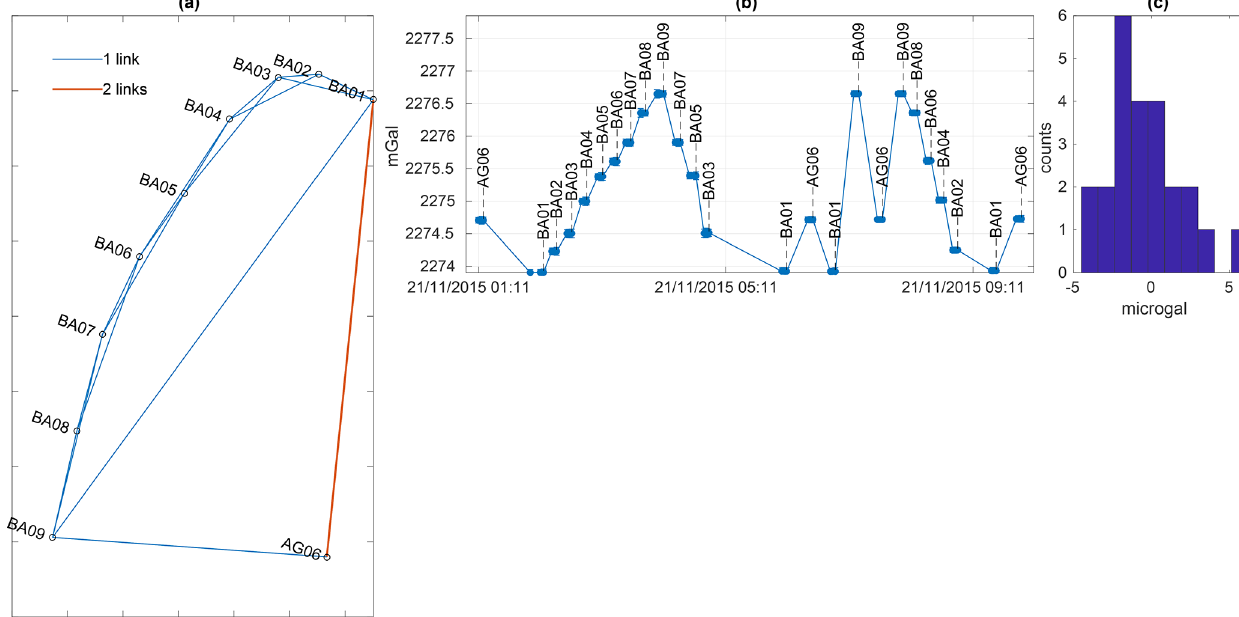
Figure A1. (a) Map view of the relative gravity network with the link between each site for the 2015 survey. (b) Gravity readings on the CG-5 at each site as a function of time. (c) Histogram of the residuals after the drift